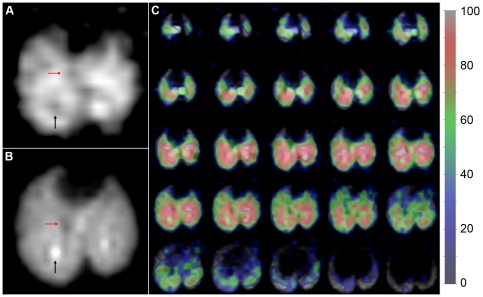
Gas-phase 129Xe MR imaging.
A. Axial slice from an EC infusion image (EC flow ∼15 ml/min) acquired with a nominal isotropic resolution of 2×2×2 mm3. Black arrow indicates a signal void in the image corresponding to the location of a major airway. Red arrow indicates a hypointense region that likely corresponds to a large blood vessel. B. Axial slice from the corresponding ventilation image acquired with 1×1×2 mm3 nominal resolution. Black arrow indicates a large airway in the same location as the signal void in A (also marked by a black arrow). Red arrow points to a hypointense region corresponding to the red arrow in B. C. Complete 3D, gas-phase, EC infusion image (color) overlaid on the 3D ventilation image (grayscale). The signal intensity of the EC infusion image, in arbitrary units, is indicated in the legend.